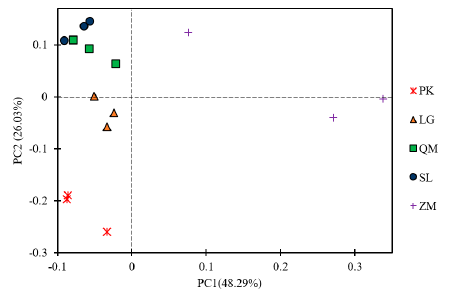
Figure 5. Principal component analysis (PCA) of soil microbial community composition. QM; Quercus mongolica ; LG: Larix gmelinii ; PK: Pinus koraiensis ; SL: Shrubland; ZM: Zea mays .